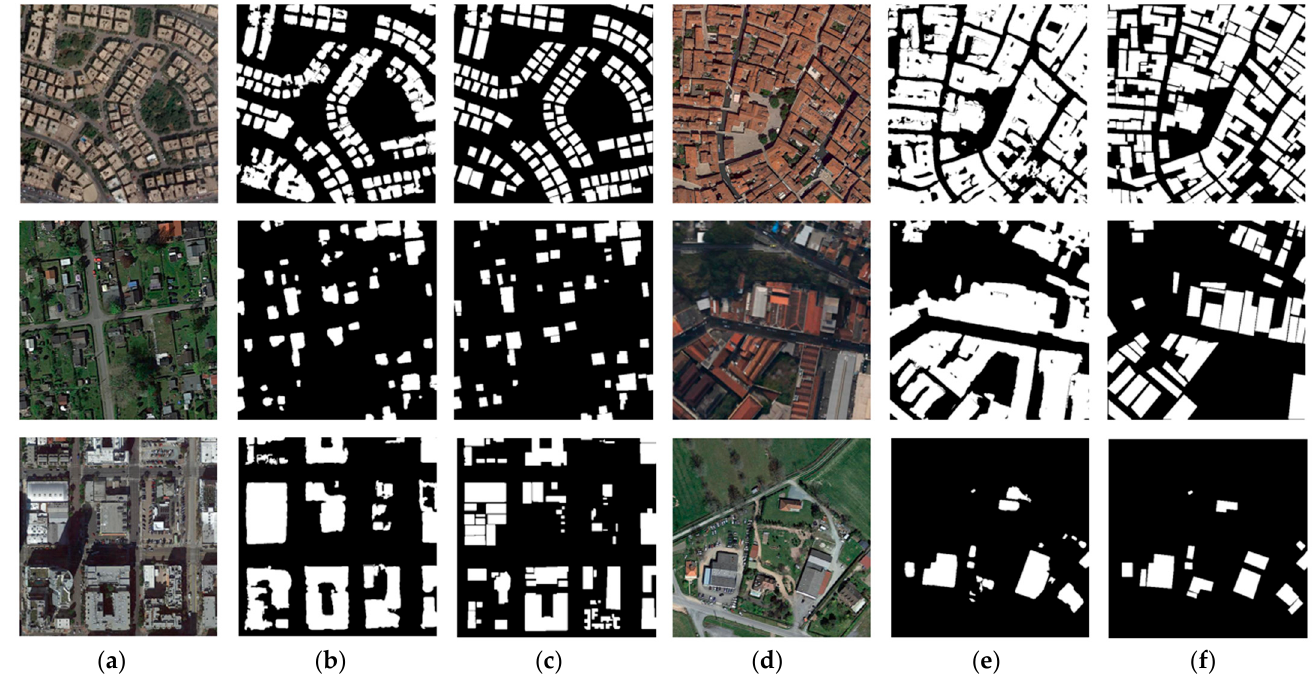
Figure 7. Some building extraction results on WHU Satellite Dataset I. The white area indicates the building footprint. ( a ) and ( d ) are the remote sensing image. ( b ) and ( e ) are the extraction results of our framework with the UNet model. ( c ) and ( f ) are the ground truth.